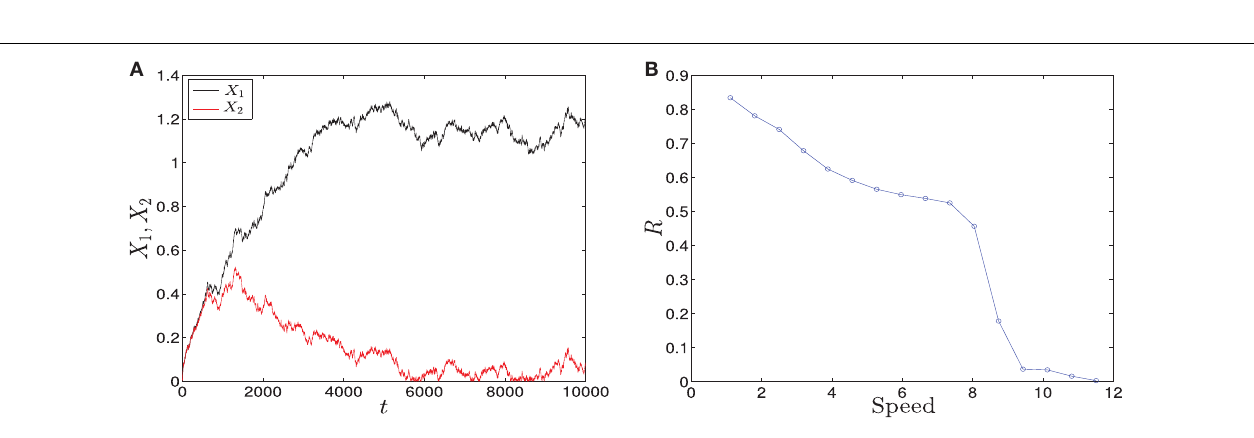
FIGURE 8 |Trajectories and parameter sweeping speed . (A) Time evolution of X 1 and X 2 in the asymmetric supercritical pitchfork bifurcation. (B) The effect of increasing the speed of crossing the critical region on the distribution of trajectories in the attractors for 10000 iterations. As the